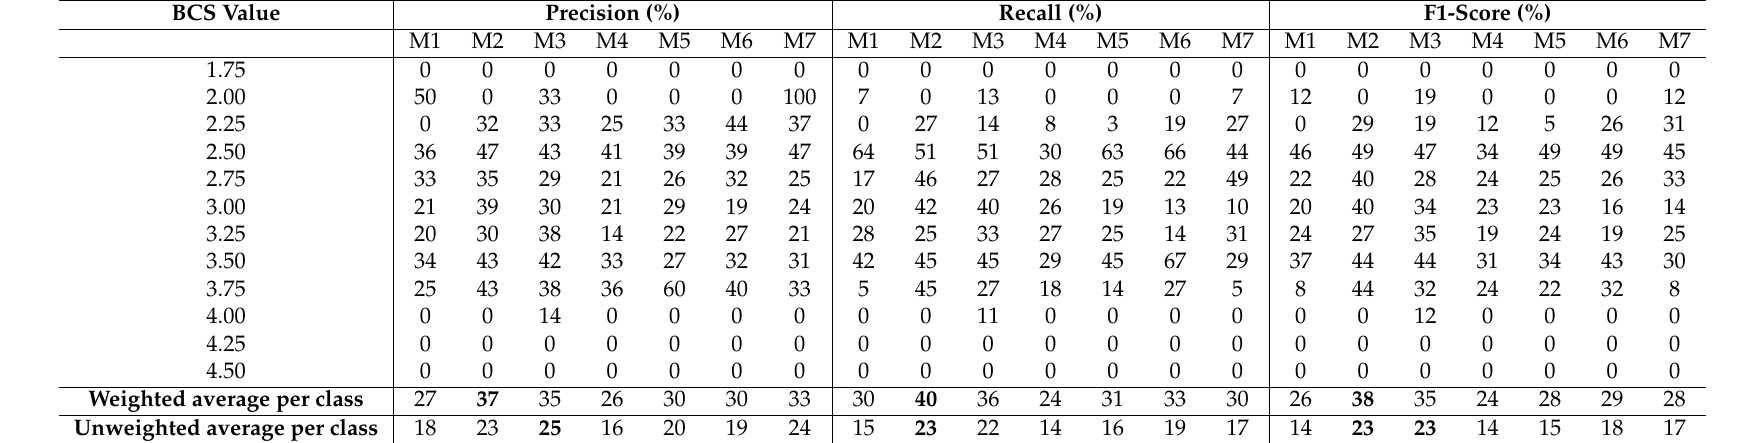
Table 3. Classification measures for exact predictions. Best results are in bold.